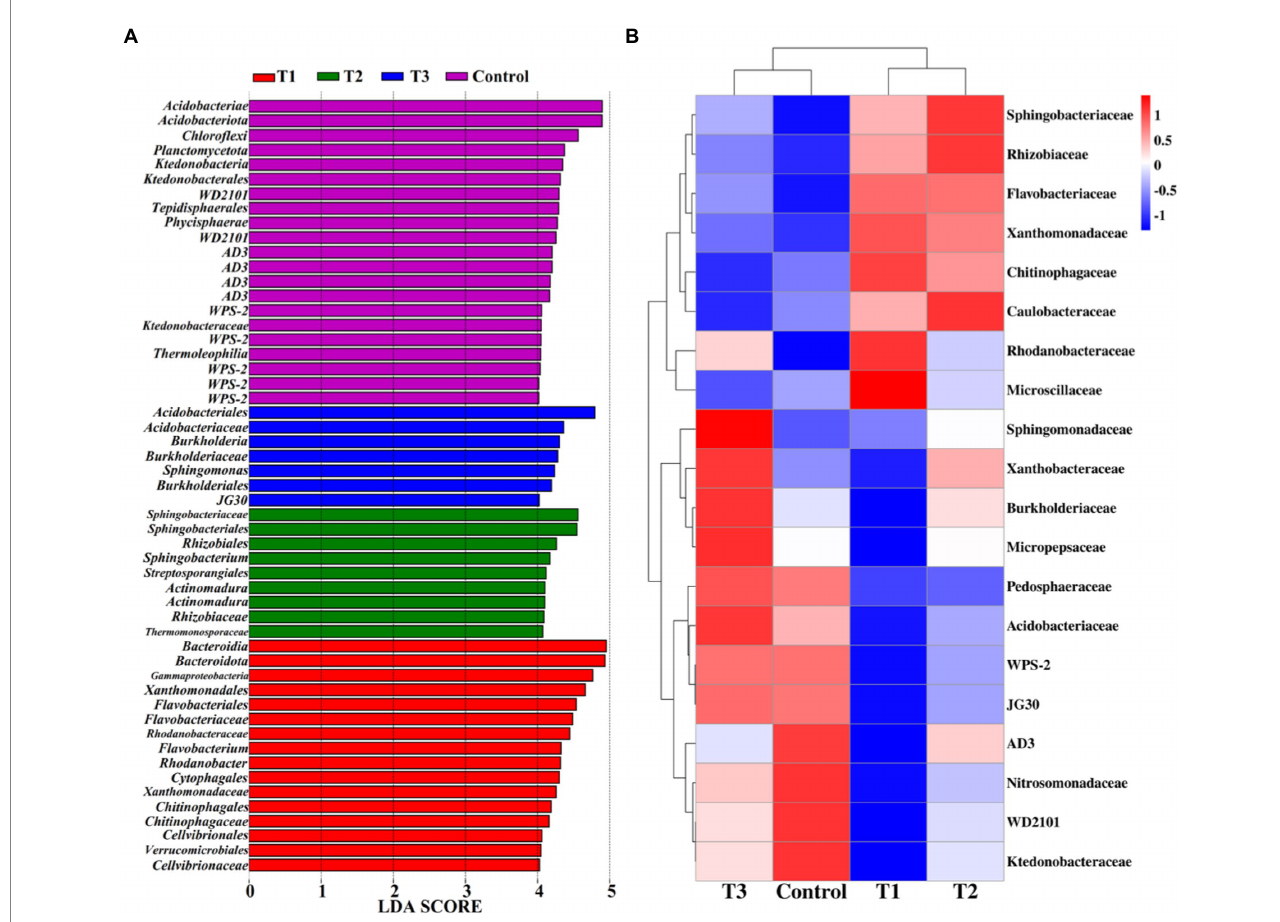
FIGURE 5 Linear discriminant analysis (LDA) effect size (LeFSe) of the bacterial taxa (A) , which identifies the most differentially abundant taxa among MF-HZ23 and CCF in different treatments. Only taxa with LDA values greater than 4 ( p < 0.05) are shown. Hierarchical clustering analysis and heat map at the family level (B) . The tree plot represents a clustering analysis of the top 20 bacteria at family levels according to their Person correlation coefficient matrix and relative abundance, the upper tree plot represents a clustering analysis of soil samples according to the Euclidean distance of data. T1: MF-HZ23 at 3.00 kg/m 2 ; T2: